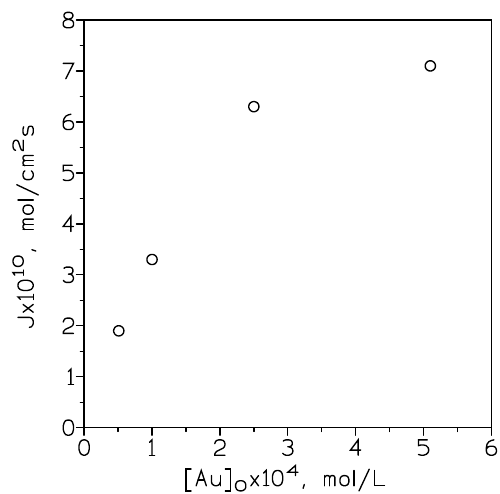
Figure 2. Influence of the initial gold(III) concentration on the initial flux. Feed phase: Gold(III) in 1 M HCl. Carrier phase:0.23 M ionic liquid in Solvesso 100 immobilized on Durapore support. Receiving phase: 0.1 M NaSCN.